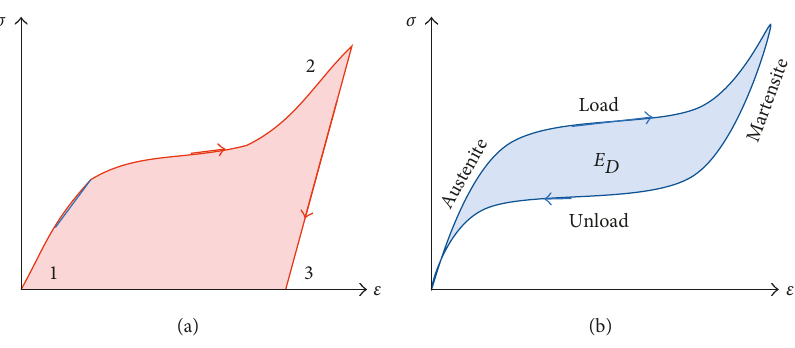
Figure 1: Representation of the two effects of an SMA. (a) SME and (b)